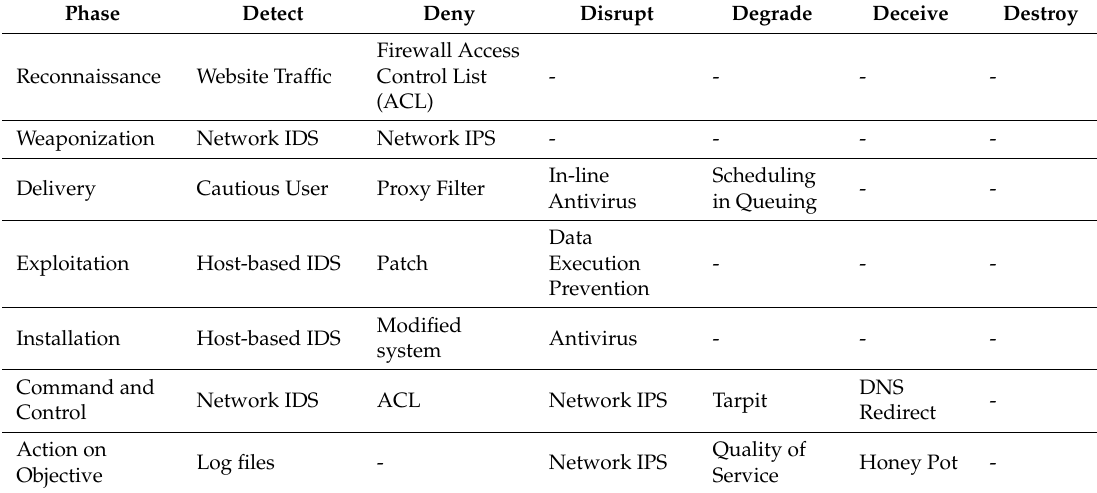
Table 3. Matrix for